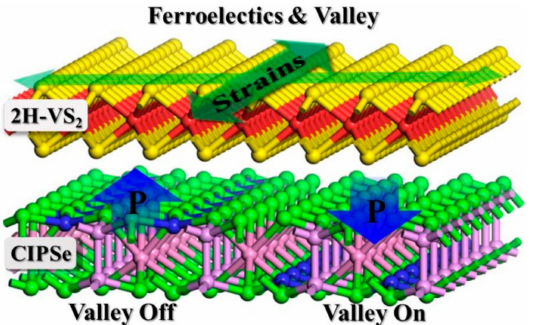
Figure 5. The schematic design for applications of the tunable ferrovalley of 2H–VS 2 monolayer under both in–plane strains and ferroelectric CIPSe substrate in 2H–VS 2 /CIPSe